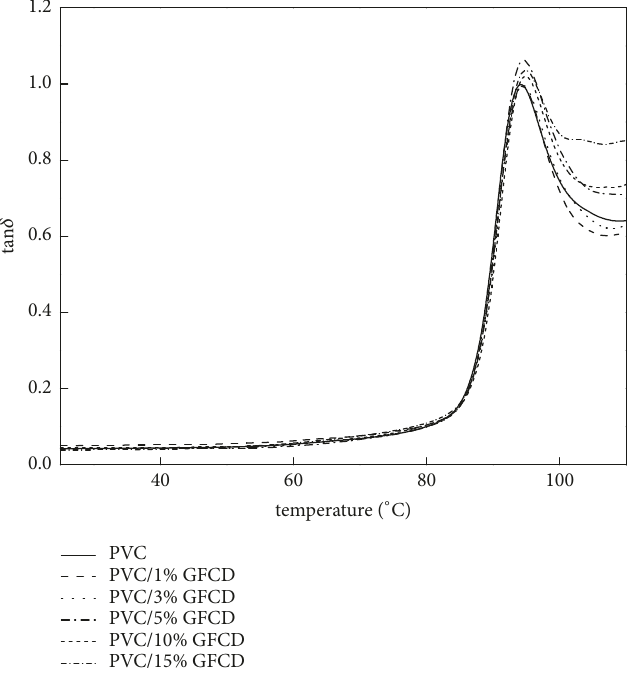
Figure 12: The relationship between the loss factor tan 𝛿 versus temperature of PVC and PVC/GFCD composites.